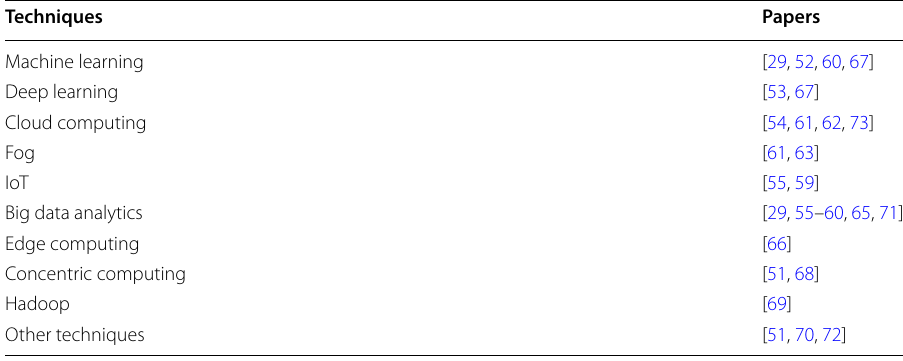
Table 1 Analysis based on utilized methods